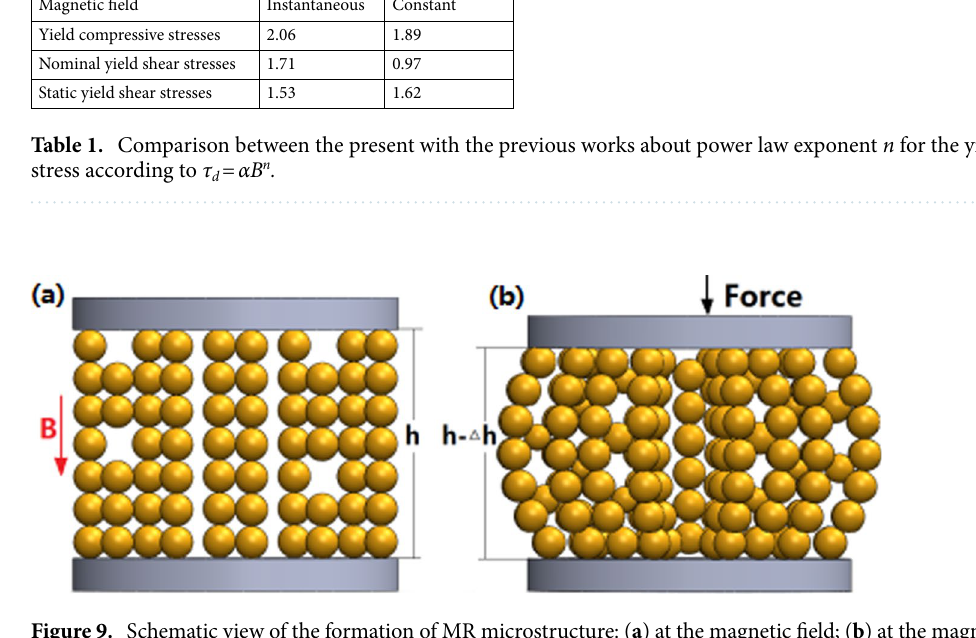
Figure 9. Schematic view of the formation of MR microstructure: ( a ) at the magnetic field; ( b ) at the magnetic field under